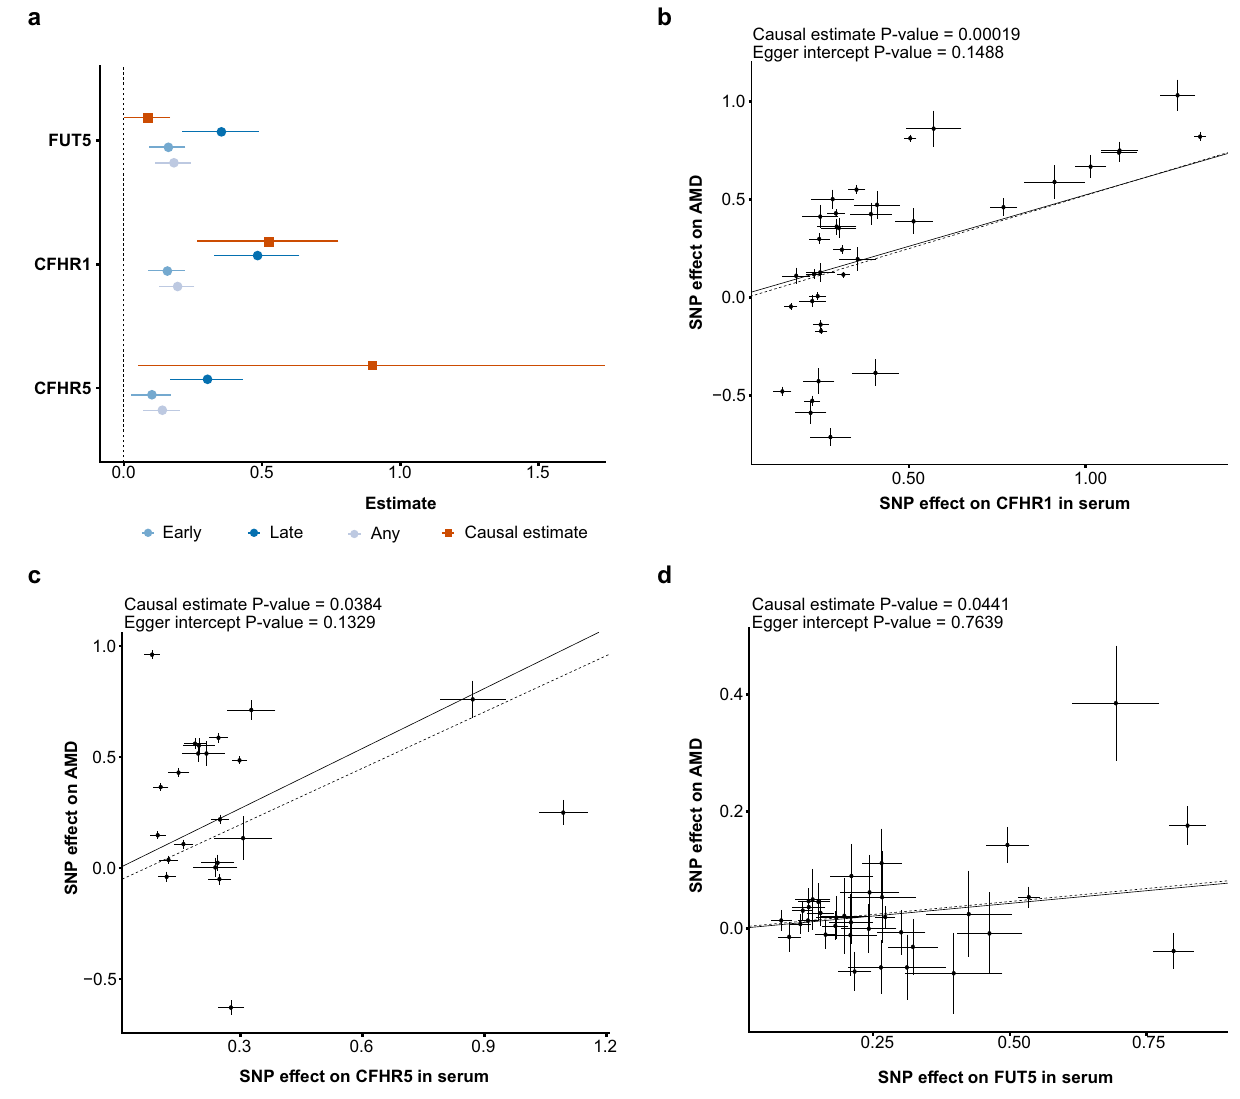
Fig. 7 MR analysis identi fi es serum proteins that are causally related to AMD. a The causal estimate (squares) from the two-sample MR analysis compared to the observational estimates (circles) for each of the fi ve proteins with cis -acting instruments and associated with AMD in the observational study (AGES-RS, n = 5457). As each protein could have different observational coef fi cients depending on which de fi nition of early AMD (see Methods section) was used, it was decided to select and display the coef fi cient for each de fi nition which had the lower adjusted P -value. The causal estimator for CFHR1, CFHR5 and FUT5 was signi fi cant (FDR < 0.05) and positive. Each center data point shows the estimate as beta = log(OR) for the observational estimate and as described in Methods for the causal estimate, along with 95% con fi dence intervals as error bars. The number of patients in each AMD- related group in the AGES-RS cohort is shown in Supplementary Data 1. b Scatterplot for the CFHR1 protein supported as having a causal effect on AMD in a two-sample MR analysis. The fi gure demonstrates the estimated effects of the respective cis -acting genetic instruments on the serum CFHR1 levels in AGES-RS ( x -axis) and risk of AMD through a GWAS provided by the IAMDGC consortium ( n = 16,144 AMD patients) 10 (y-axis). The solid line indicates the generalized weighted causal estimate ( β = 0.524, SE = 0.126, P = 0.00019, two-sided), while the dotted line shows the MR-Egger regression. Similar plots as in b are shown for c CFHR5 ( β = 0.899, SE = 0.407, P = 0.0384, two-sided), and d FUT5 ( β = 0.087, SE = 0.041, P = 0.0441, two-sided). Each data point in the center of the scatter plots in b – d represents the SNP effect (log(OR)) on disease with vertical lines as error bars (95% CIs) versus the SNP effect (beta-coef fi cient) on the protein with horizontal lines as error bars (95% CIs). The P -values (two-sided) for the Egger intercept and the GWLS causal estimates are displayed at the top of each scatter plot. The causal estimates for the three proteins in b – d were found to be signi fi cant after adjusting the P - value with the Benjamini – Hochberg method (see Methods